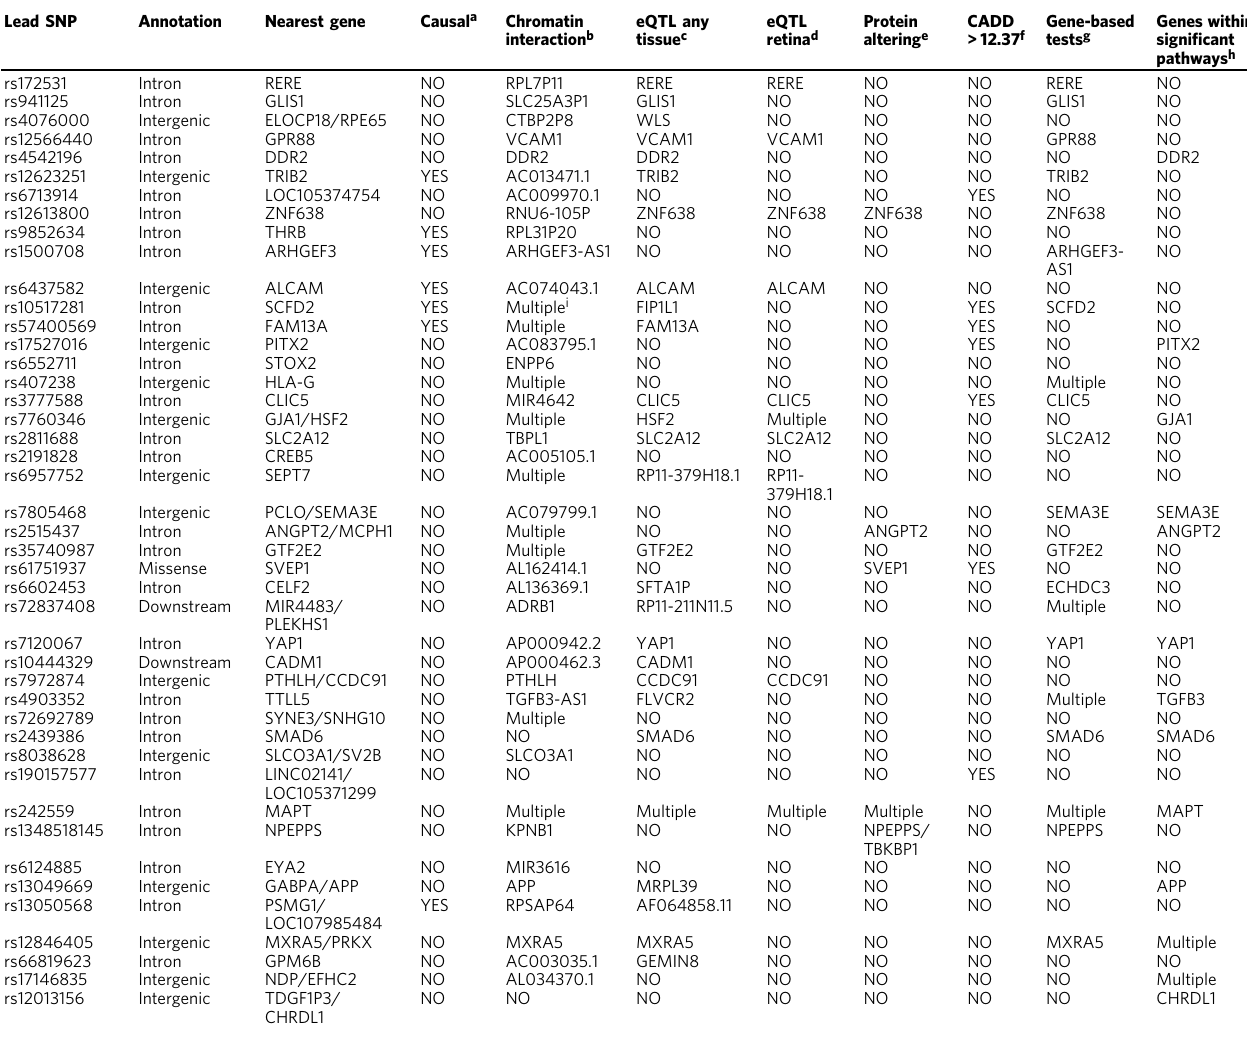
Table 1 Summary of the previously unreported POAG risk loci annotation and functional